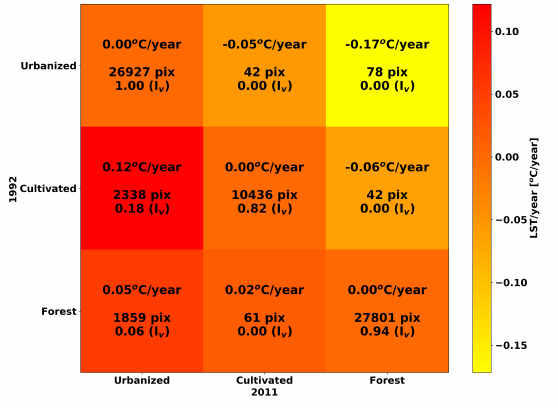
Figure 21. San Francisco MA: Detrended Rate